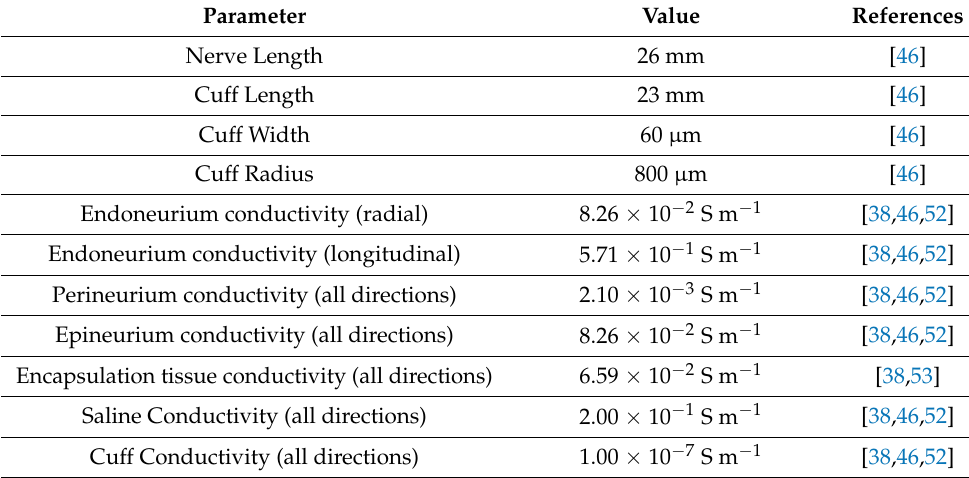
Table 1. FE mesh model